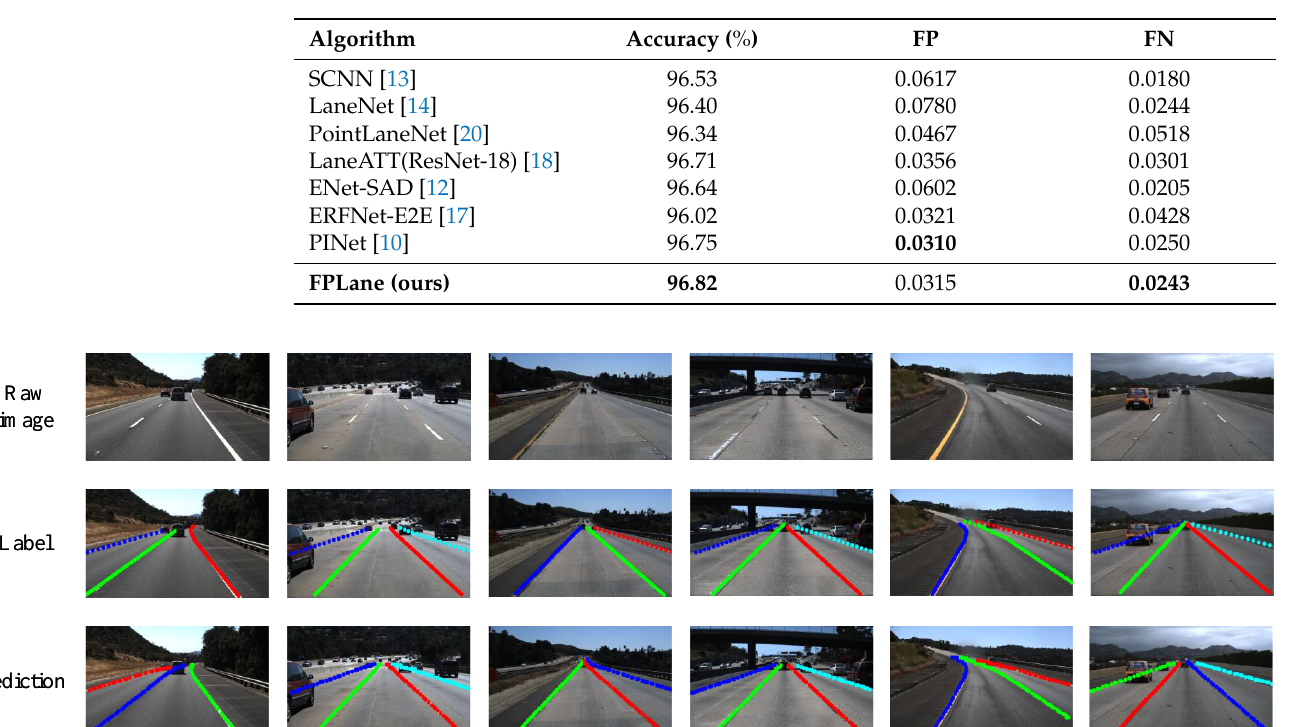
Table 3. Evaluation results on TuSimple dataset.